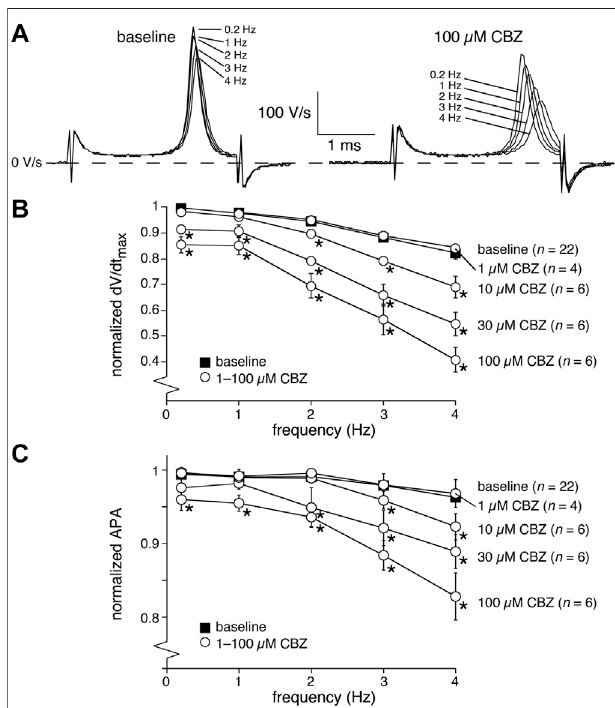
FIGURE2| Carbamazepine(CBZ)reducestheAPupstrokevelocityand amplitude of rabbit ventricular cardiomyocytes in a frequency dependent manner. (A) Superimposed typical time derivatives (dV/dt) during the AP upstroke phase at stimulus frequencies ranging from 0.2 to 4 Hz under baseline conditions (left) and in presence of 100 µM CBZ (right). (B) Average dV/dt max under baseline conditions ( fi lled squares) and in response to 1 – 100 µM CBZ (open circles) at stimulus frequencies ranging from 0.2 to 4 Hz. Values are normalized to the highest dV/dt max measured at 0.2 – 4 Hz under baseline conditions. * p < 0.05 CBZ versus baseline (Two-Way RM ANOVA). See Supplementary Figure S2 for statistical signi fi cance of the frequency dependent effects. (C) Average APA under baseline conditions ( fi lled squares) and in response to 1 – 100 µM CBZ (open circles) at stimulus frequencies ranging from 0.2 to 4 Hz. Values are normalized to the highest APA measured at 0.2 – 4 Hz under baseline conditions. * p < 0.05 CBZ versus baseline (Two-Way RM